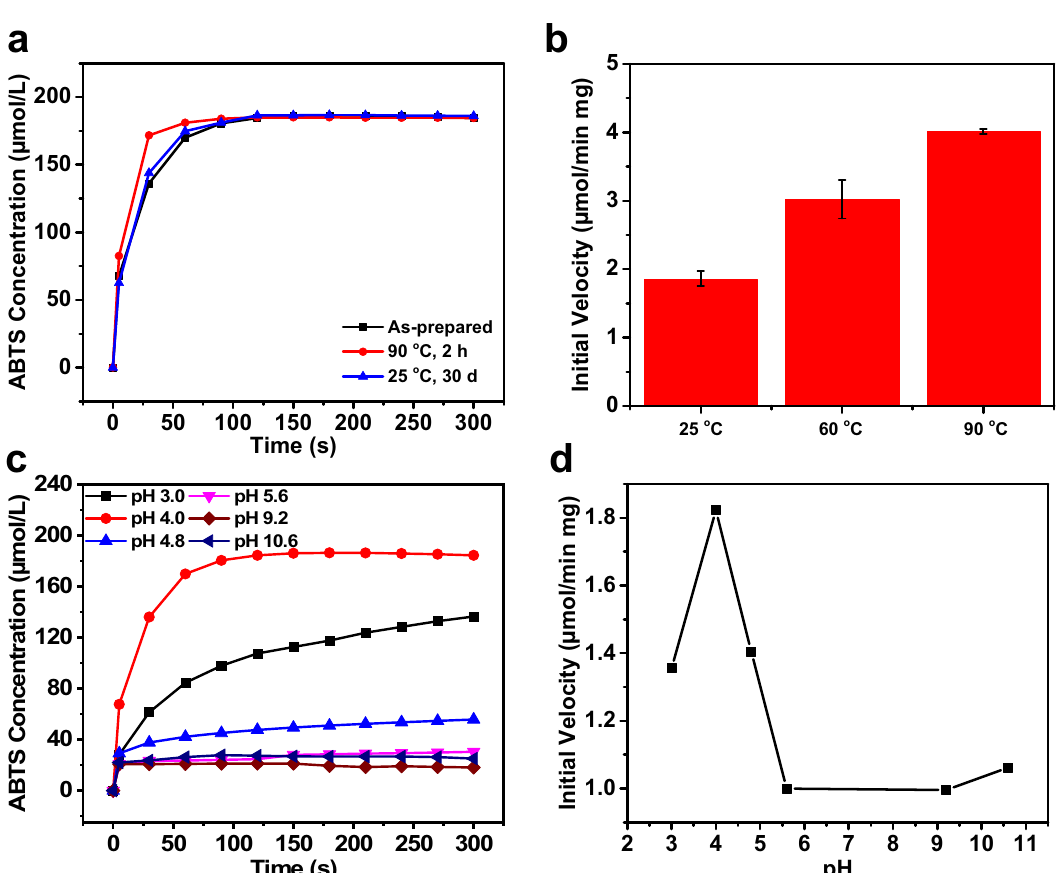
Fig. 3 Peroxidase activity of Pep-1/hemin as a function of temperature and solution pH. a Change in ABTS concentration by H 2 O 2 over time in the presence of Pep-1/hemin (black), Pep-1/hemin after incubated at 90 °C for 2 h (red), and Pep-1/hemin after incubated at room temperature for 30 days (blue). b Initial velocities of ABTS oxidation reactions in the presence of Pep-1/hemin after it has been incubated at 25, 60, and 90 °C for 2 h. The error bar represents the standard deviation of three measurements. c Change in concentration of ABTS with H 2 O 2 over time in the presence of Pep-1/hemin at different pHs. d Initial velocities of ABTS oxidation reactions in the presence of Pep-1/hemin at different